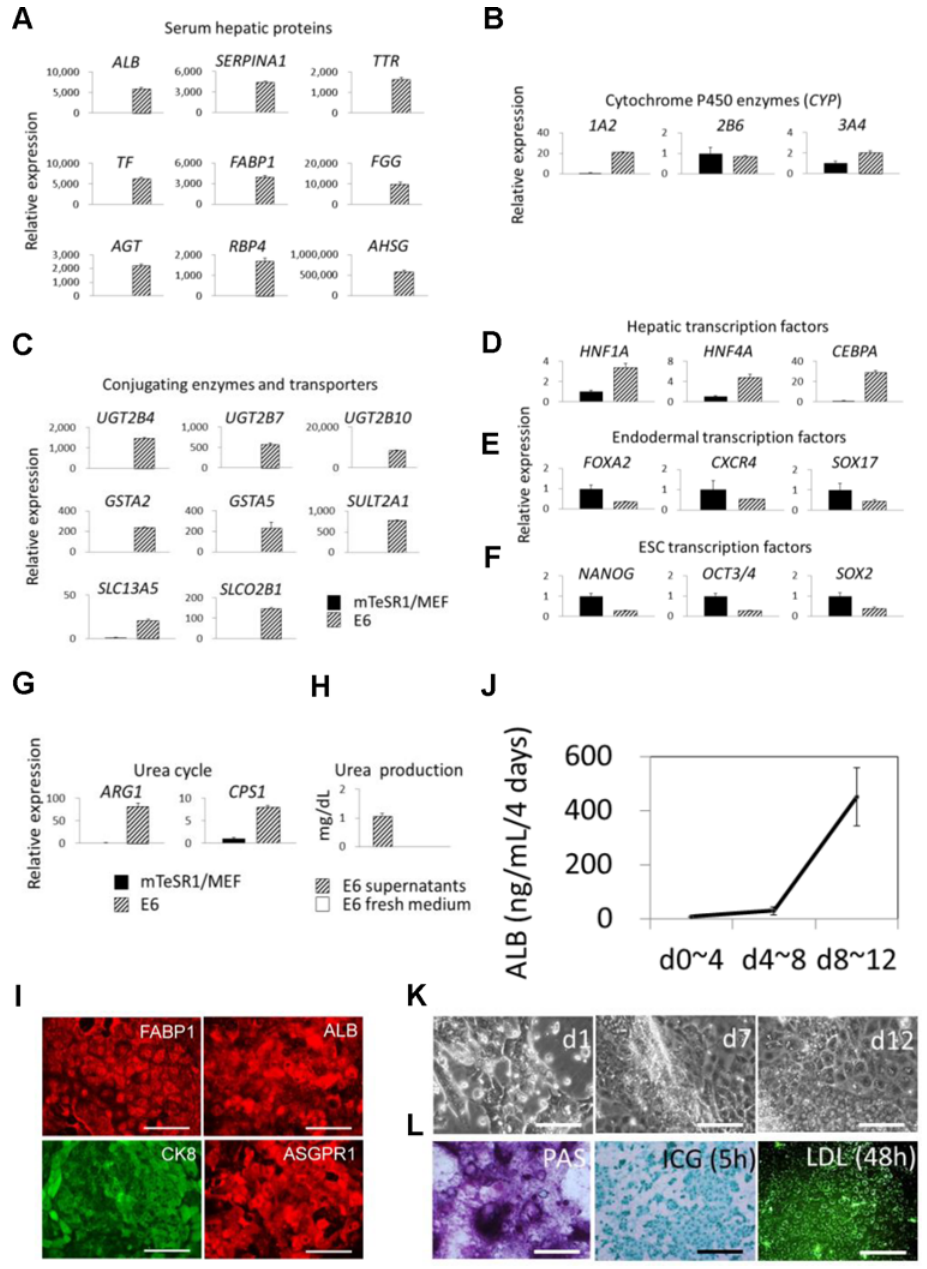
Fig 3. Autonomous hepatic differentiation of hiHSCs in Essential 6 medium. Self-renewing hiHSCs (clone AFB1-1) differentiate into hepatocyte-like cells in defined Essential 6 medium that consists simply of insulin, transferrin, selenium, and L-ascorbic acid in DMEM/F12 medium. ( A – G ) Gene expression was analyzed by quantitative RT-PCR at day 12. Relative expression is shown in the histogram. The expression is normalized to 1 in the self-renewing hiHSCs (mTeSR1/MEF) and compared to that of hepatocyte-like cells (E6). Gene symbols are shown for ( A ) serum hepatic proteins, ( B ) cytochrome P450 enzymes, ( C ) conjugating enzymes and transporters, ( D ) hepatic transcription factors, ( E ) endodermal transcription factors, ( F ) ESC transcription factors, and ( G ) urea cycle-related enzymes. Data are presented as mean+SEM and represent a minimum of three independent samples with at least two technical duplicates. ( H ) Urea production was measured by urea nitrogen detection kits on the supernatants of cells at day 12. E6 fresh medium was also measured as a negative control. Data are presented as mean+SEM and represent a minimum of three independent samples. ( I ) Immunofluorescent staining of hepatocyte-like cells for FABP1, ALB, CK8, and ASGPR1. Scale bar represents 100 μ m. ( J ) Release of ALB was measured by ELISA at